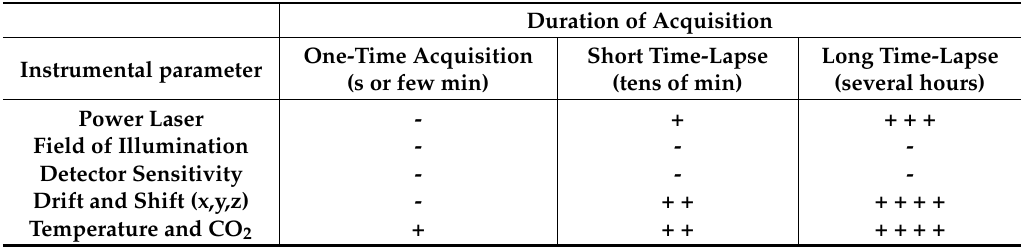
Table 3. Potential instrumental instabilities during one-time acquisition, and short and long time lapses. Duration of Acquisition One-Time Acquisition Short Time-Lapse Long Time-Lapse Instrumental parameter (s or few min) (tens of min) (several hours) Power Laser - + + + Field of Illumination - - - Detector Sensitivity Drift and Shift